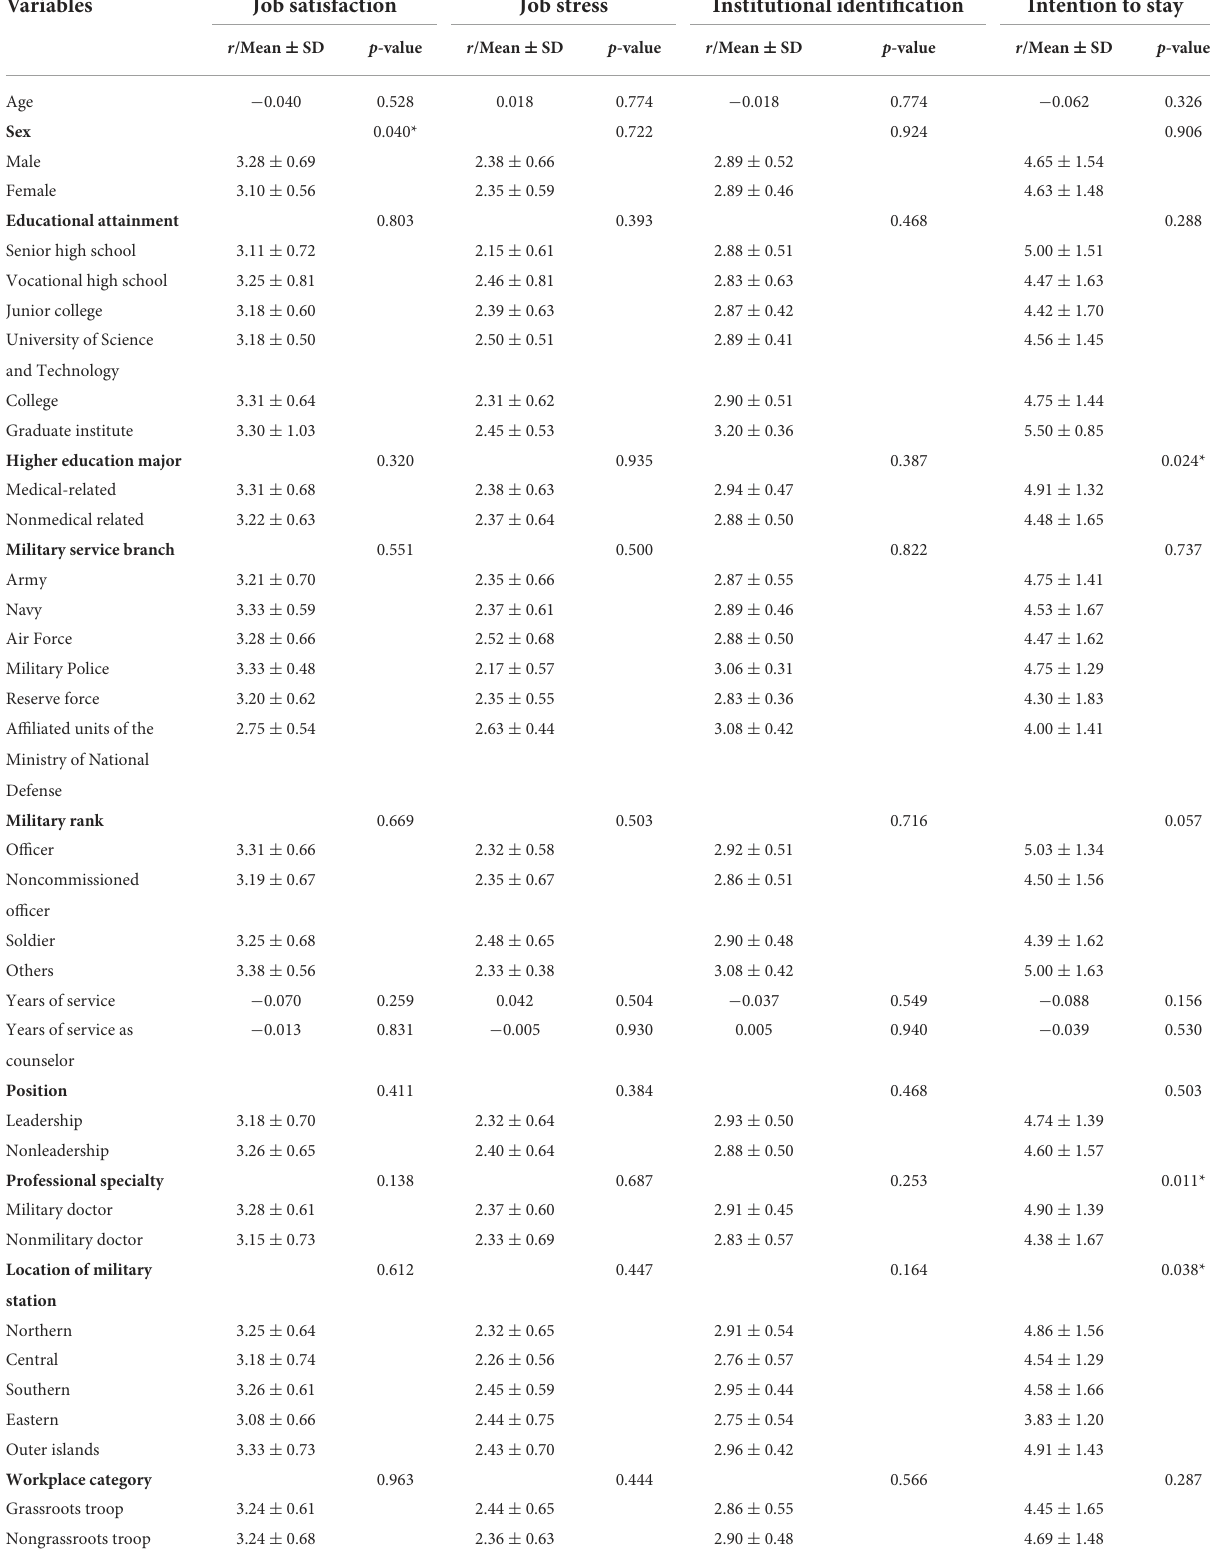
TABLE 4 Univariate analysis of the